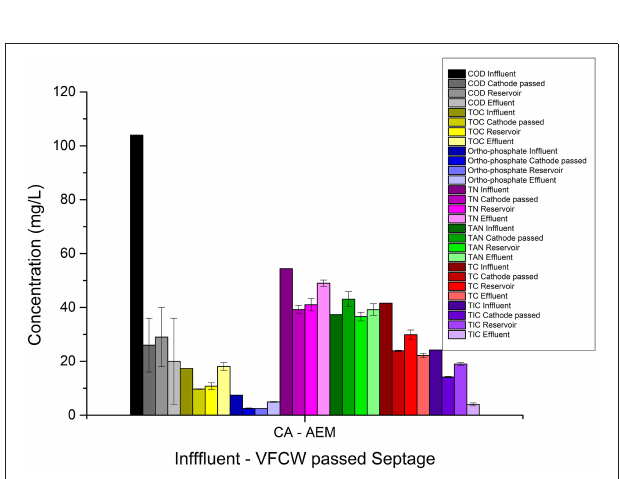
FIGURE 11 | Graphical representation of variation in wastewater parameters as the feed flows through the cathode chamber and then through the anode chamber via reservoir during electrolysis in AEM based ECR.